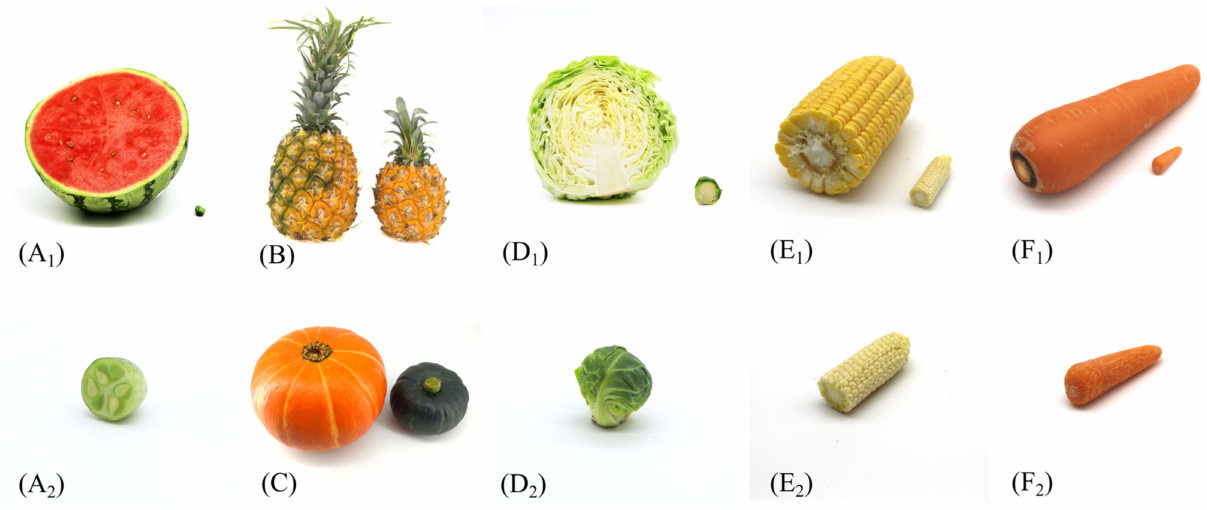
Figure 1. Sample photos. ( A 1 ) Normal watermelon and mini watermelon; ( A 2 ) mini watermelon; ( B ) normal pineapple and mini pineapple; ( C ) normal pumpkin and mini pumpkin; ( D 1 ) normal cabbage and mini cabbage; ( D 2 ) mini cabbage; ( E 1 ) normal maize and mini maize; ( E 2 ) mini corn; ( F 1 ) normal carrot and mini carrot; ( F 2 ) mini